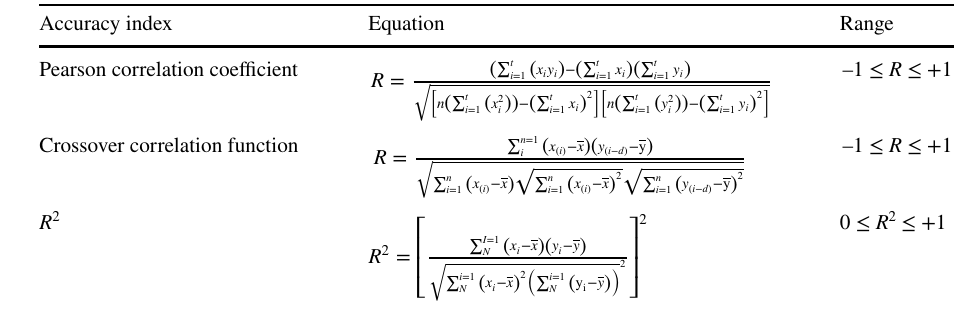
Table 4 Equations of the accuracy indices